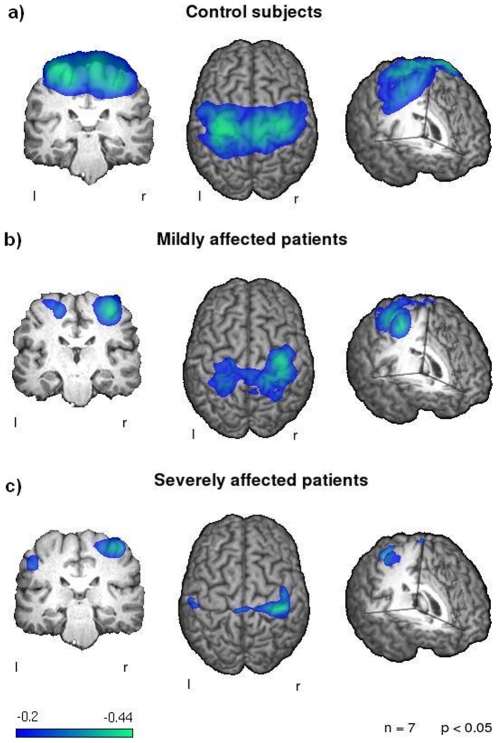
Event related desynchronization.Changes in the beta-frequency-band during swallowing execution compared to the resting stage. The color bar represents the t-value. a) Control subjects show a strong and bilateral activation of the primary sensorimotor cortex. b) In the MDG weaker activation of both sensorimotor cortices can be found. The right hemispheric activation is stronger compared to the left side. c) In the SDG only little activation of the left hemisphere is observable. The right hemispheric activation is reduced compared to healthy controls and to the MDG. The maximum of activation is located more posterior compared to the control group, corresponding to the postcentral gyrus.